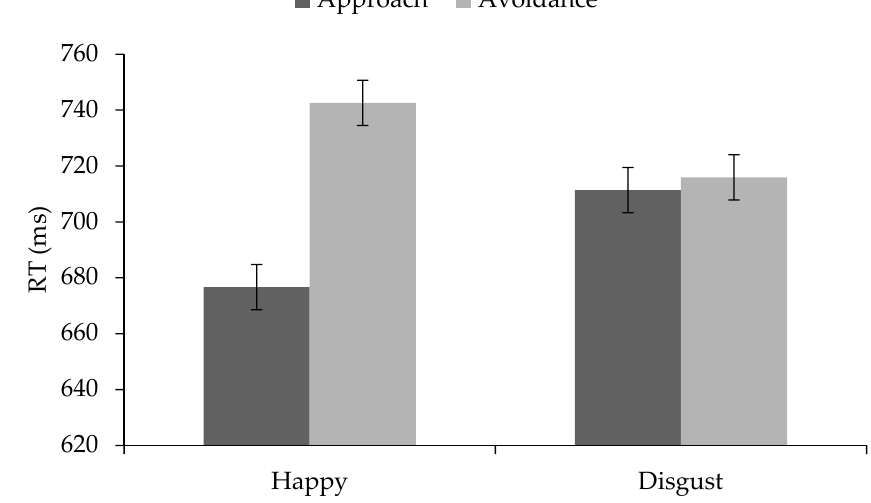
Figure 3. Mean reaction times (RTs) to happy and disgusted faces from Study 2. Error bars represent standard error of the mean.